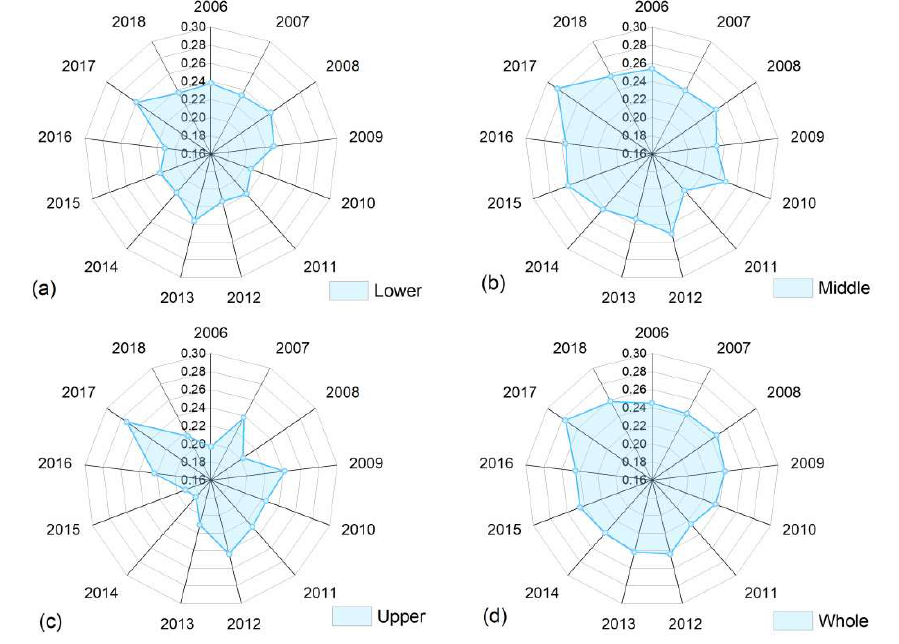
Figure 3. The σ -convergence test results for the YRB during the period from 2006 to 2018; ( a – d ) are σ -convergence test results for the lower, middle, and upper reaches and the whole basin, respec- tively.